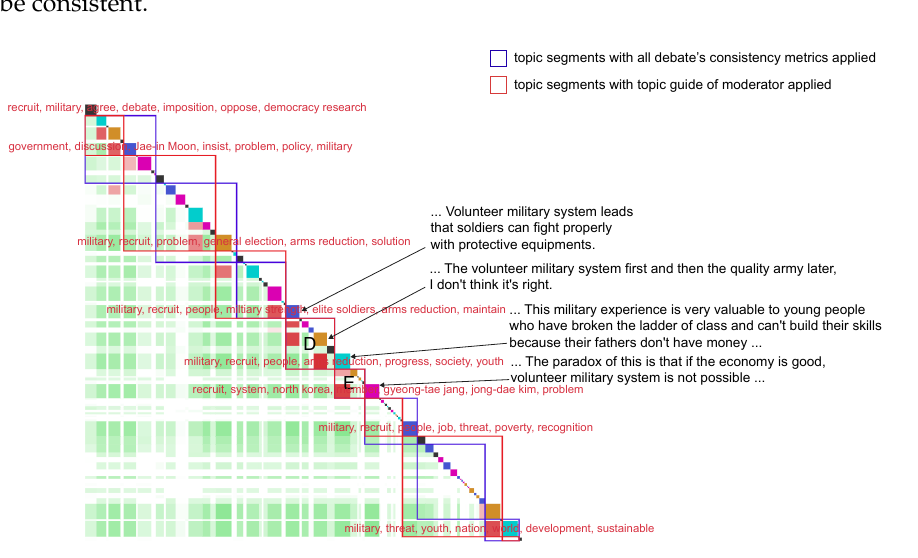
Figure 32. Result of comparing a case where weight of “chain of arguments and counterarguments” was applied and a case where all weights of debate consistency metrics were applied. Red squares are topic segments of a result weighted only by “chain of arguments and counterarguments”, and blue squares are topic segments of a result weighted by all debate consistency